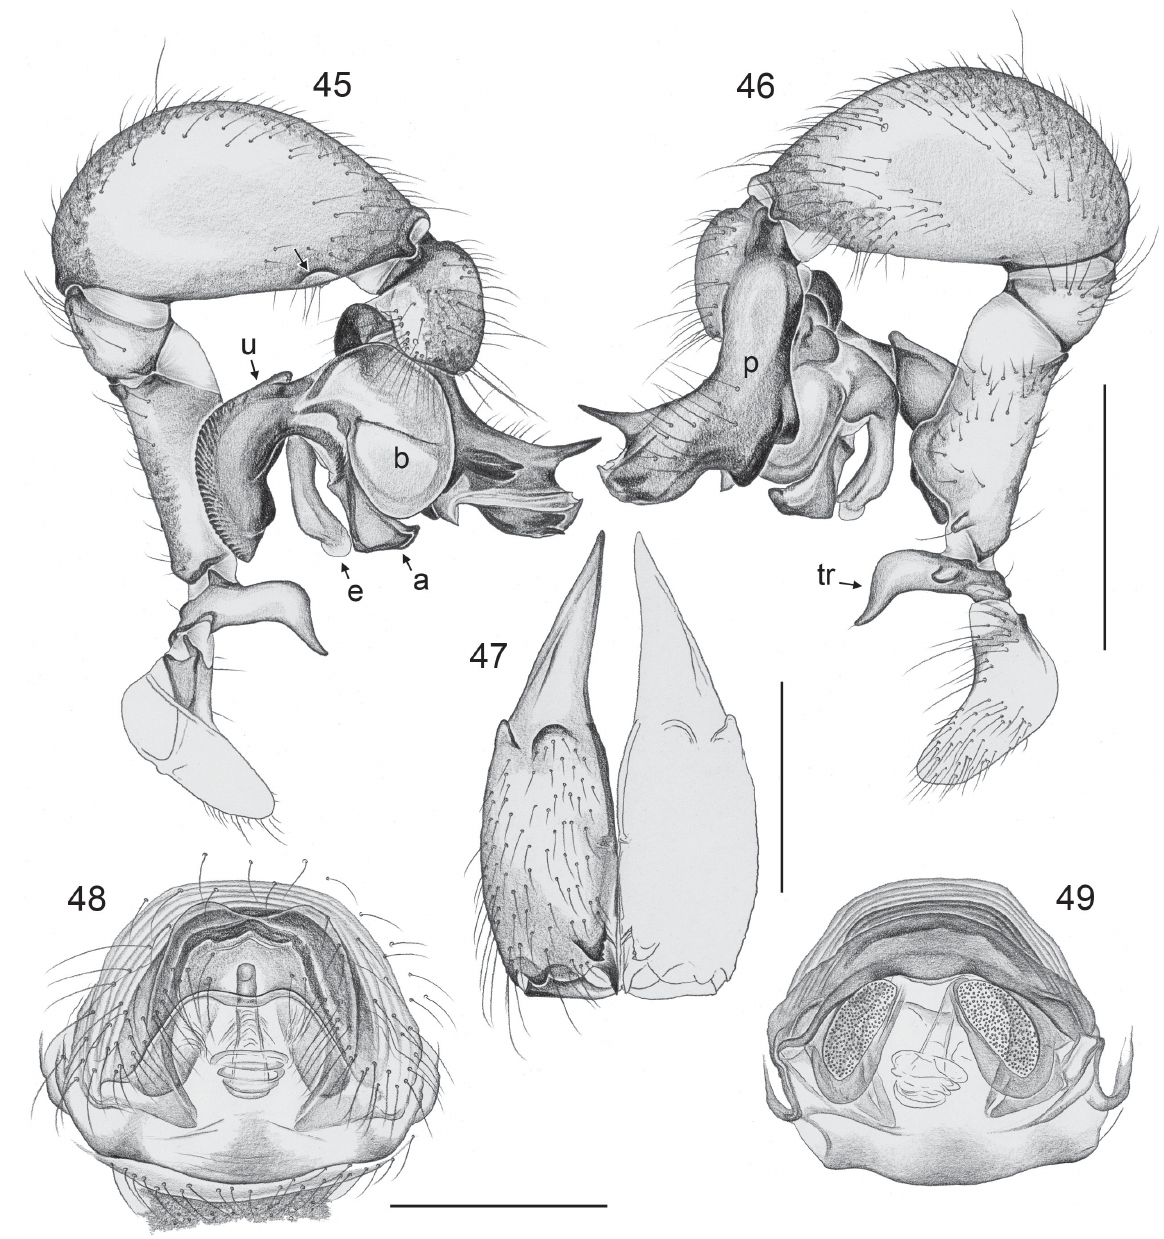
Figs 45–49. Pholcus kawit Huber, sp. nov., ZFMK Ar 15505. 45–46 . Left male palp, prolateral and retrolateral views (arrow points at ventral cavity of tibia). 47 . Male chelicerae, frontal view. 48– 49 . Cleared female genitalia, ventral and dorsal views. Scale lines: 45–46 = 1 mm; 47–49 = 0.5